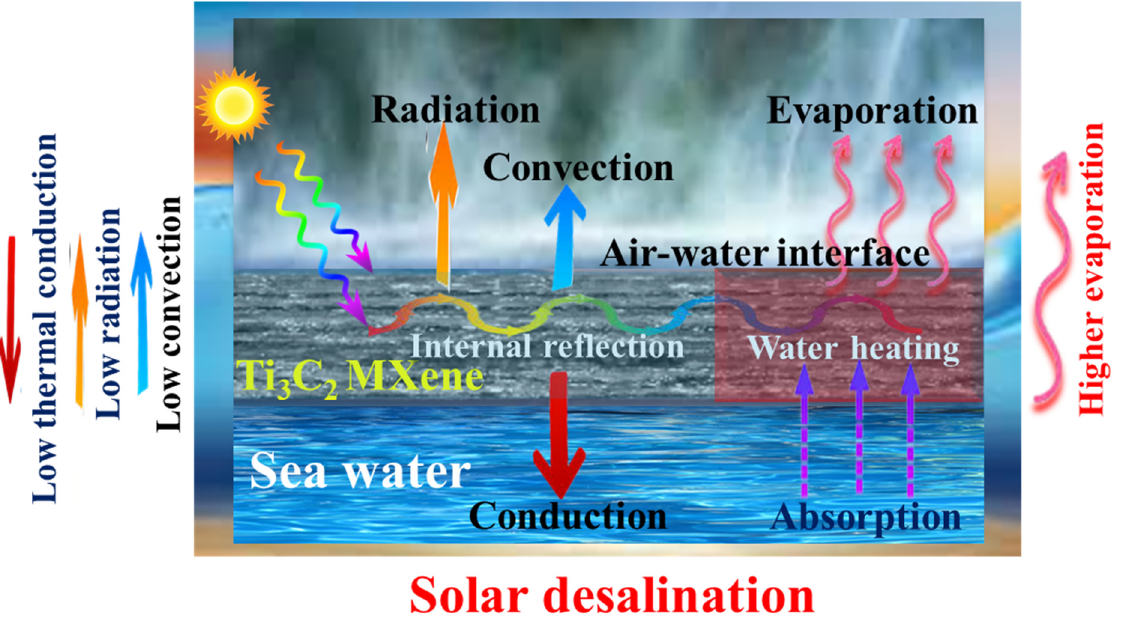
Figure 2. Prominent figures of merits of Ti 3 C 2 MXenes during solar desalination process.